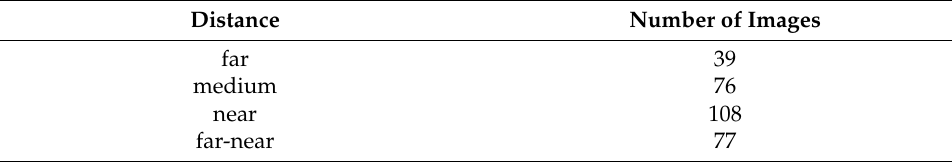
Table 3. Distance distribution of the dataset.